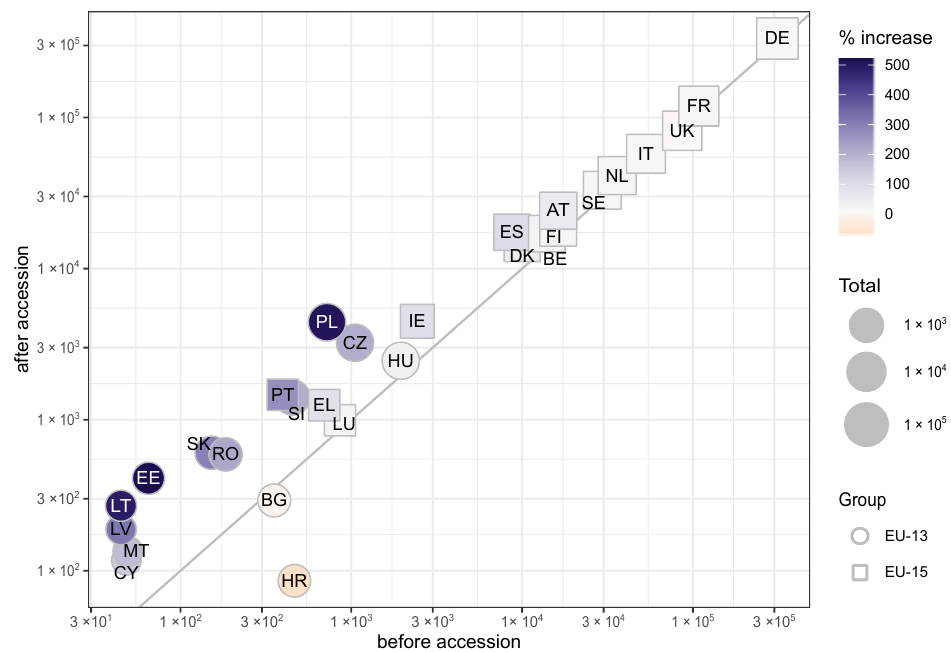
Figure 4. Number of patents before and after accession with the percentage of increase for a given country. The diagonal line marks zero change due to